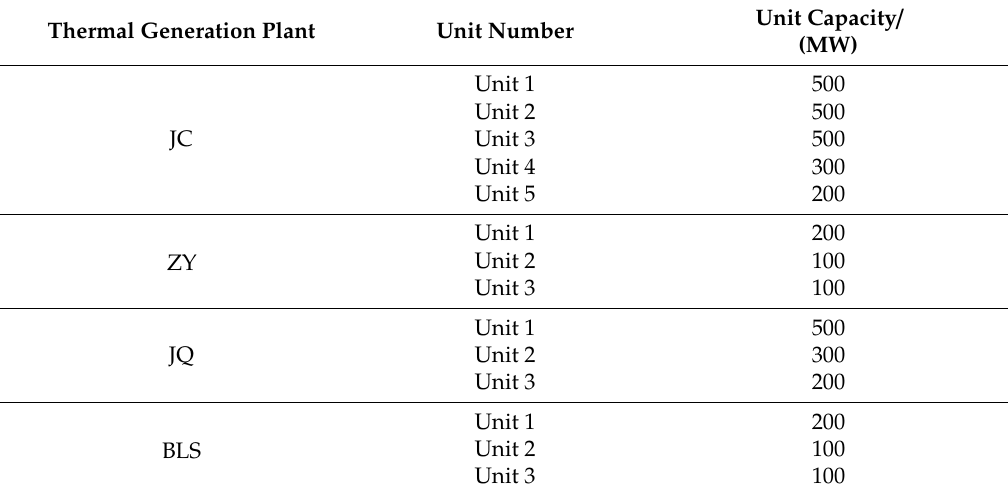
Figure 8. Simplified diagram of the large-scale wind power base sending-side system in Gansu Province. Table 1. Capacities of units in each thermal generation plant.